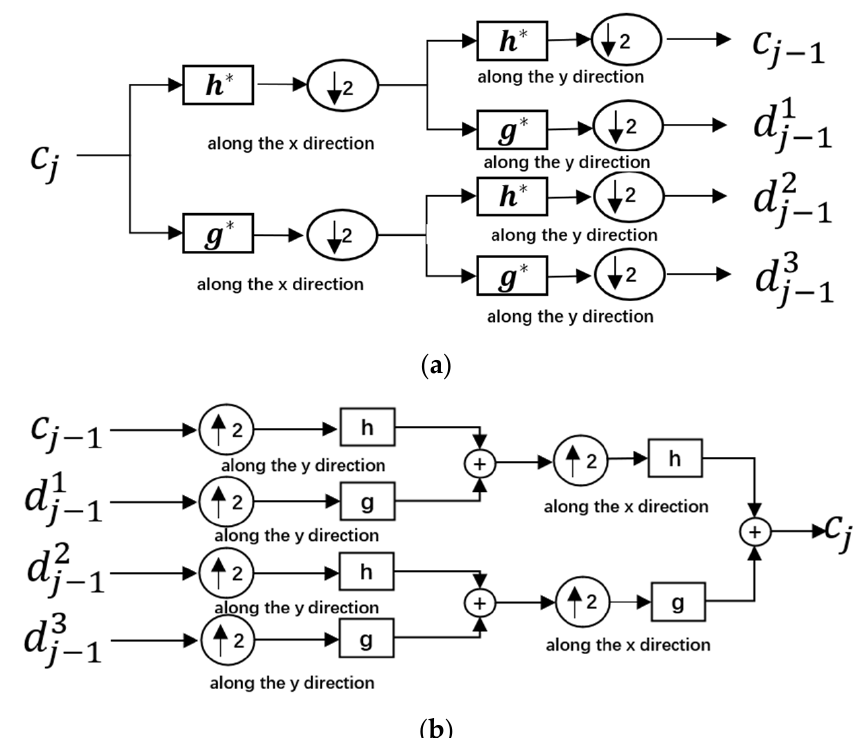
Figure 2. Filter bank representation of two-dimensional Mallat fast algorithm. ( a ) Wavelet decomposition. ( b ) Wavelet reconstruction.